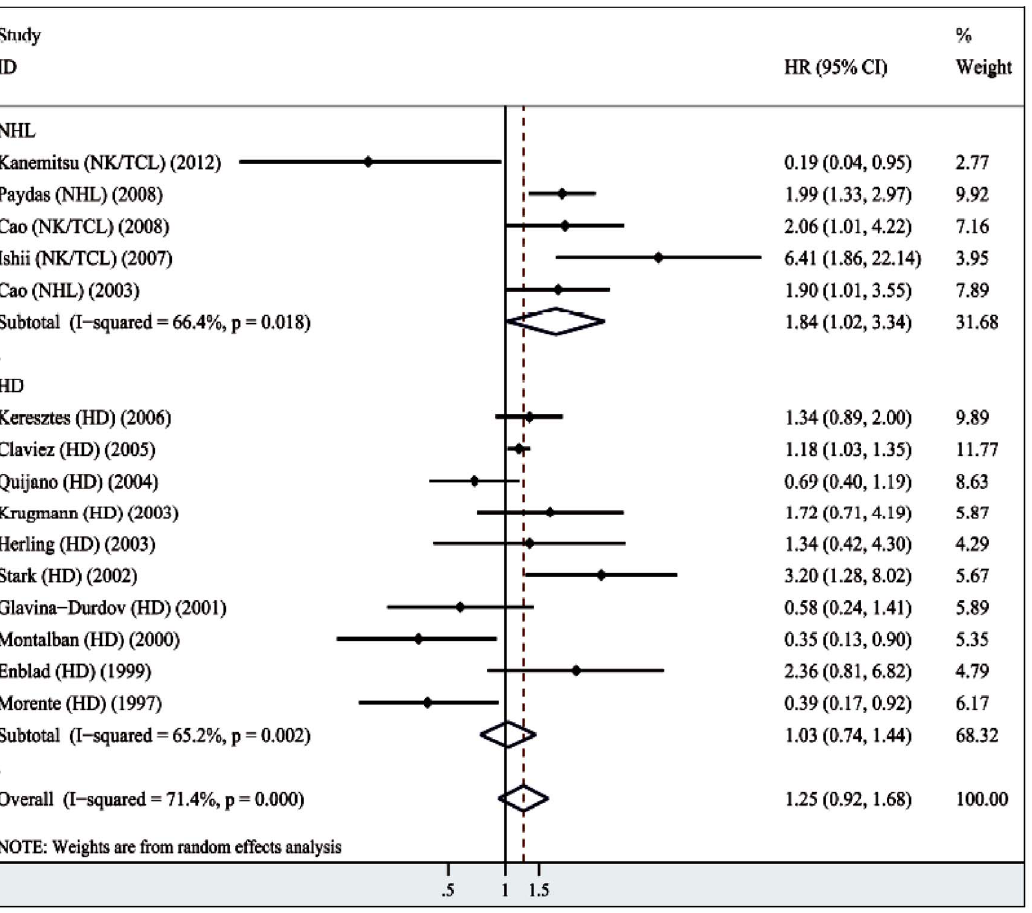
Figure 2. Forest plot of the hazard ratios (HR) and 95% confidence intervals (CI) of each study on association of LMP1 expression with lymphoma (random-effect model) and with histological types of lymphomas.